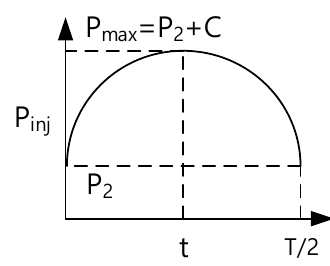
Figure 2. The simplified injection pressure characteristics at the nozzle inlet.